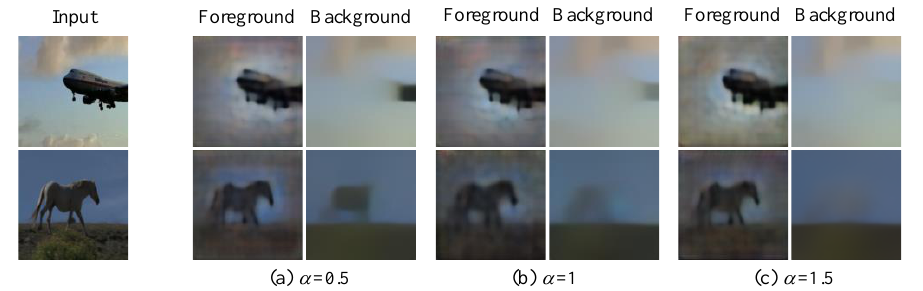
Figure 4. The experimental results of different α for the gradient loss. The foreground information is completely filtered out in the background with the increase of α